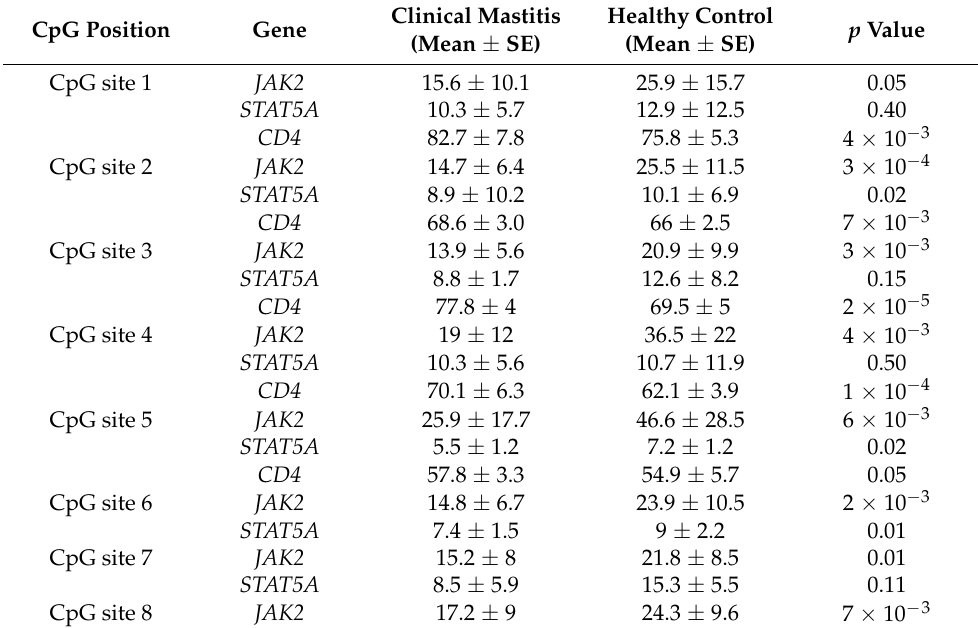
Figure 1. Results of bisulfite pyrosequencing showing aberrant methylation in clinically mastitic cow and healthy controls in almost all of the CpG sites in the genes under study: ( a ) JAK2 , ( b ) STAT5A , ( c ) CD4. Table 2. DNA methylation levels of CpG sites in 1 kb promoter regions of the JAK2 , STAT5A , and CD4 genes in clinically mastitic and healthy